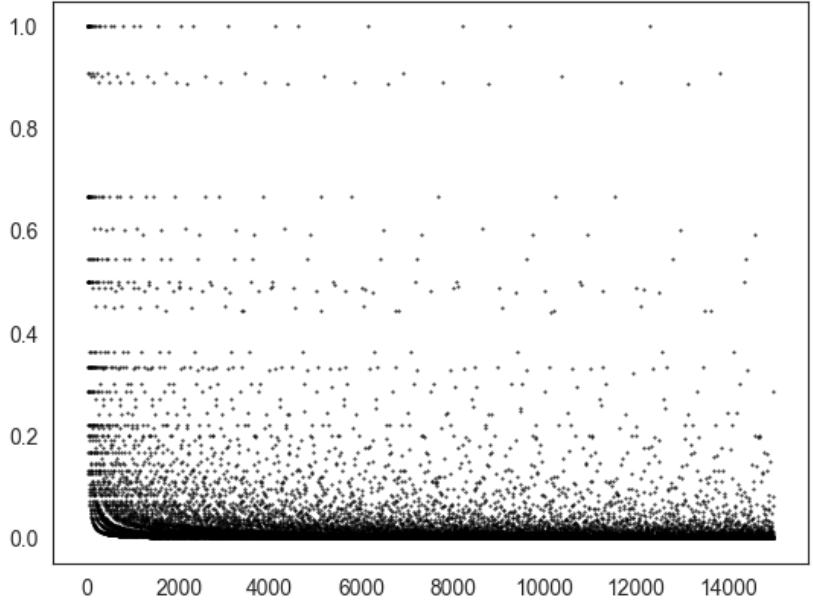
Figure 3. Plot of M r (ordinate) versus m (abscissa) up to m = 15,000. The points at M r = 1 are m values of the form 2 a 3 b for all nonnegative integers, a and b = 1 or 2, as per Theorem